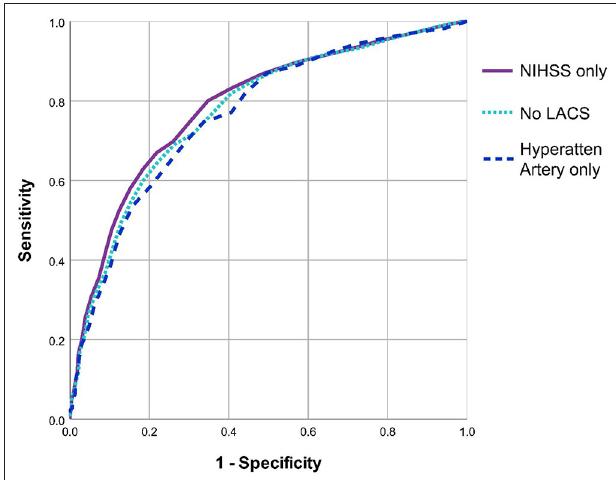
FIGURE 2 | Comparison of ROC curves for three methods used to define the subgroup most likely to have medium-large ischaemic lesions. All three ROC analyses sought an NIHSS threshold to discriminate patients with and without medium-large ischaemic lesions. The first analysis includes all patients (i.e., uses NIHSS alone, n = 2890), the second excludes patients with a lacunar stroke syndrome ( n = 2569), the third only includes patients with a hyperattenuating artery on baseline brain CT ( n = 711). NIHSS, National Institutes of Health Stroke Scale. LACS, Lacunar Stroke.